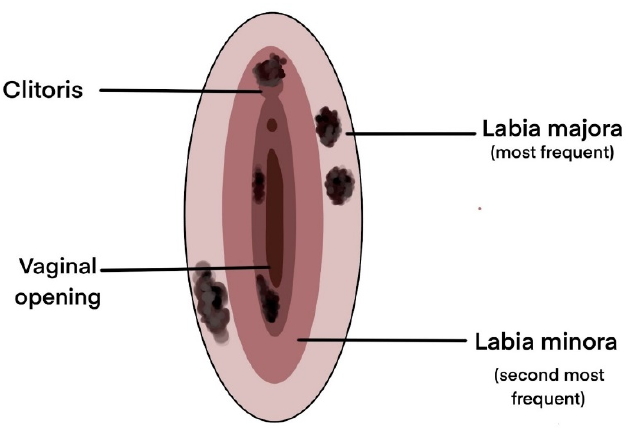
Figure 1. Most common sites for vulvar melanomas [15,36,47,57–59].